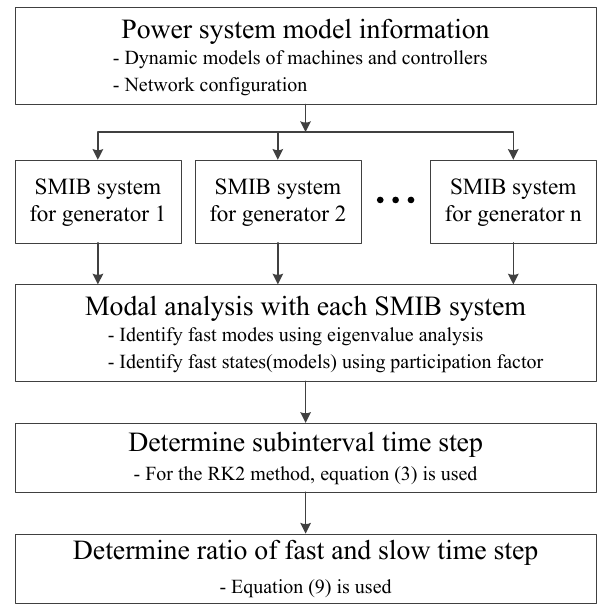
Figure 4. Flowchart of the proposed approach.